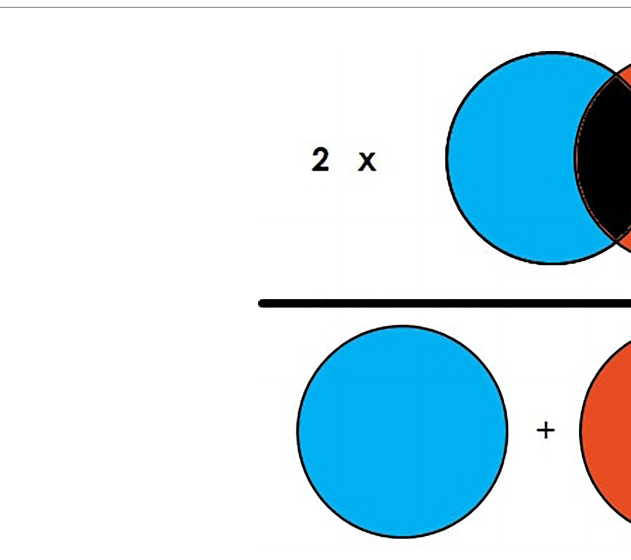
FIGURE 4 | Illustration of Dice Similarity Coef fi cient